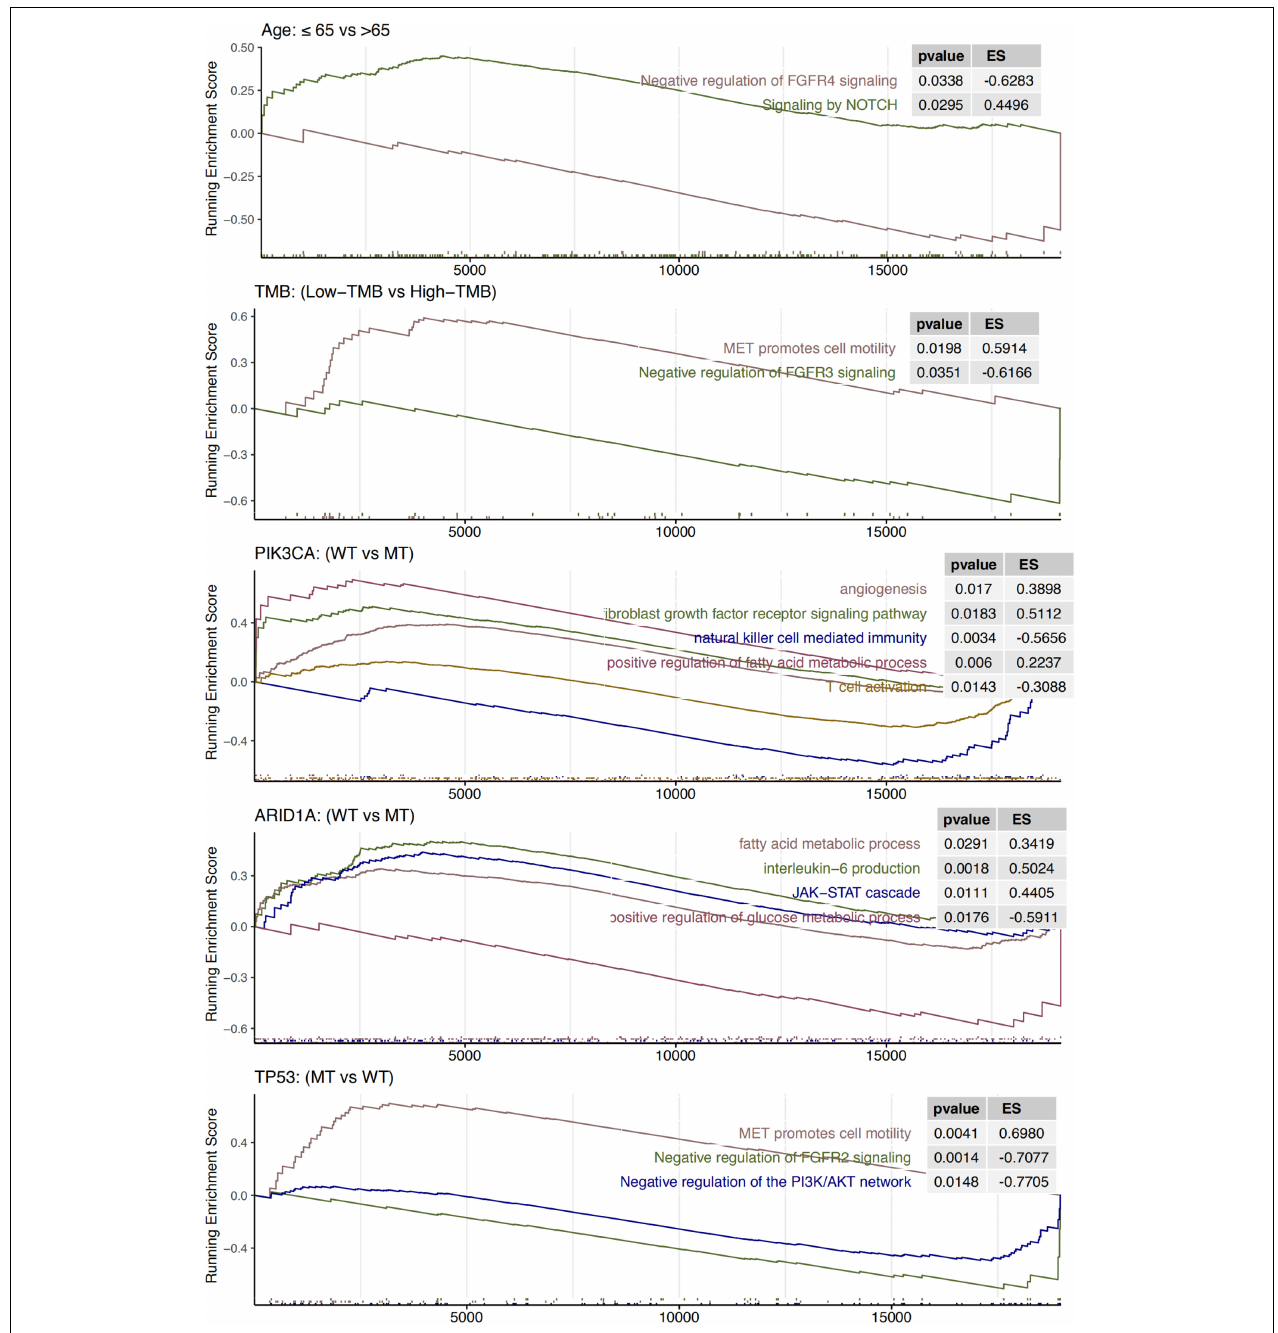
FIGURE 6 | Results of gene set enrichment analysis. The following subgroups served as control groups: age > 65 years, high TMB, ARID1A-MT, PIK3CA-MT, and TP53-WT. ES > 0 indicates that the corresponding pathways are significantly enriched in the experimental groups. Colors of curves correspond to the font colors of the pathway